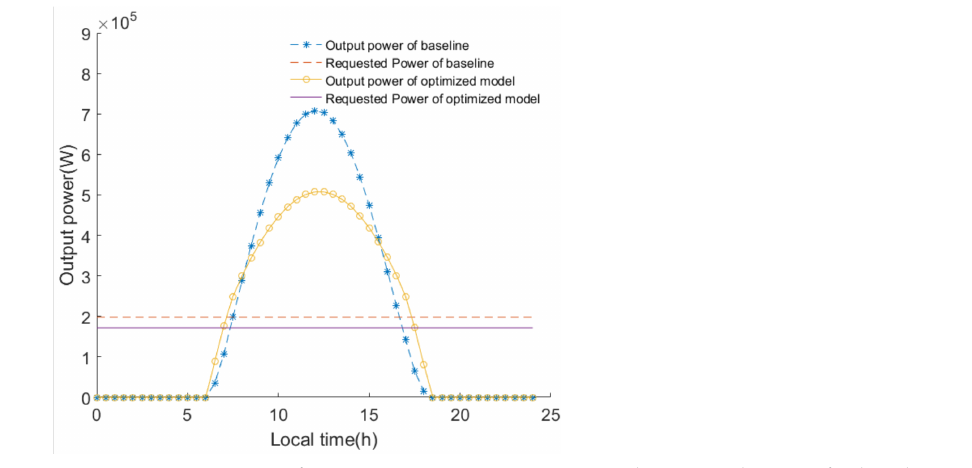
Figure 9. Comparison of instantaneous output power and requested power for baseline and opti- mized airship.